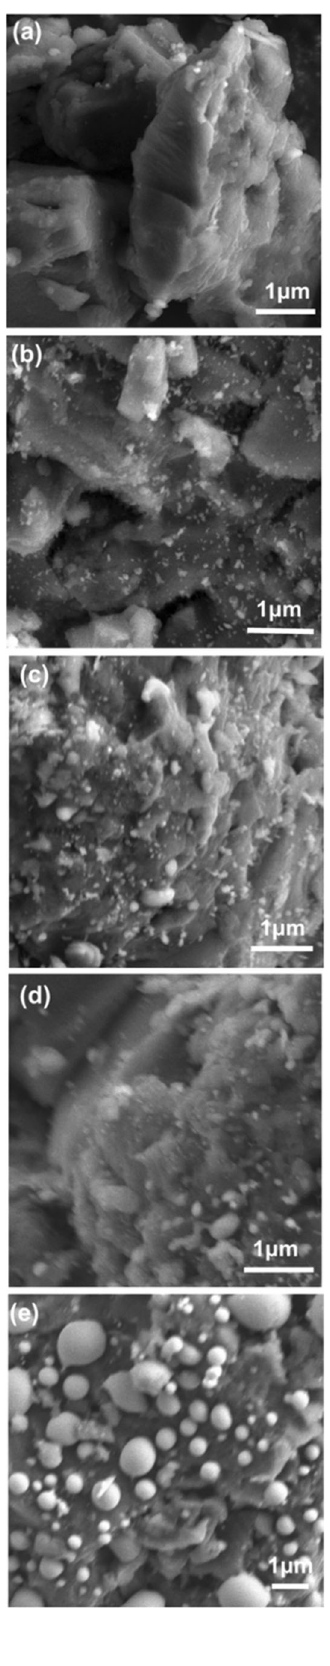
b Fig. 2 SEM images of five samples: a raw coal; b Py1073 char;